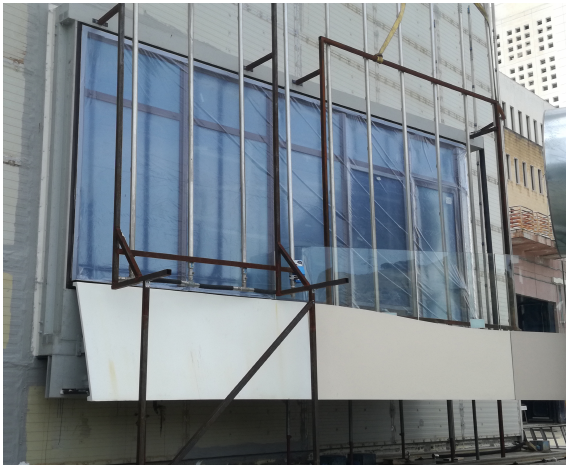
Figure 2. Air permeability test on mock-up